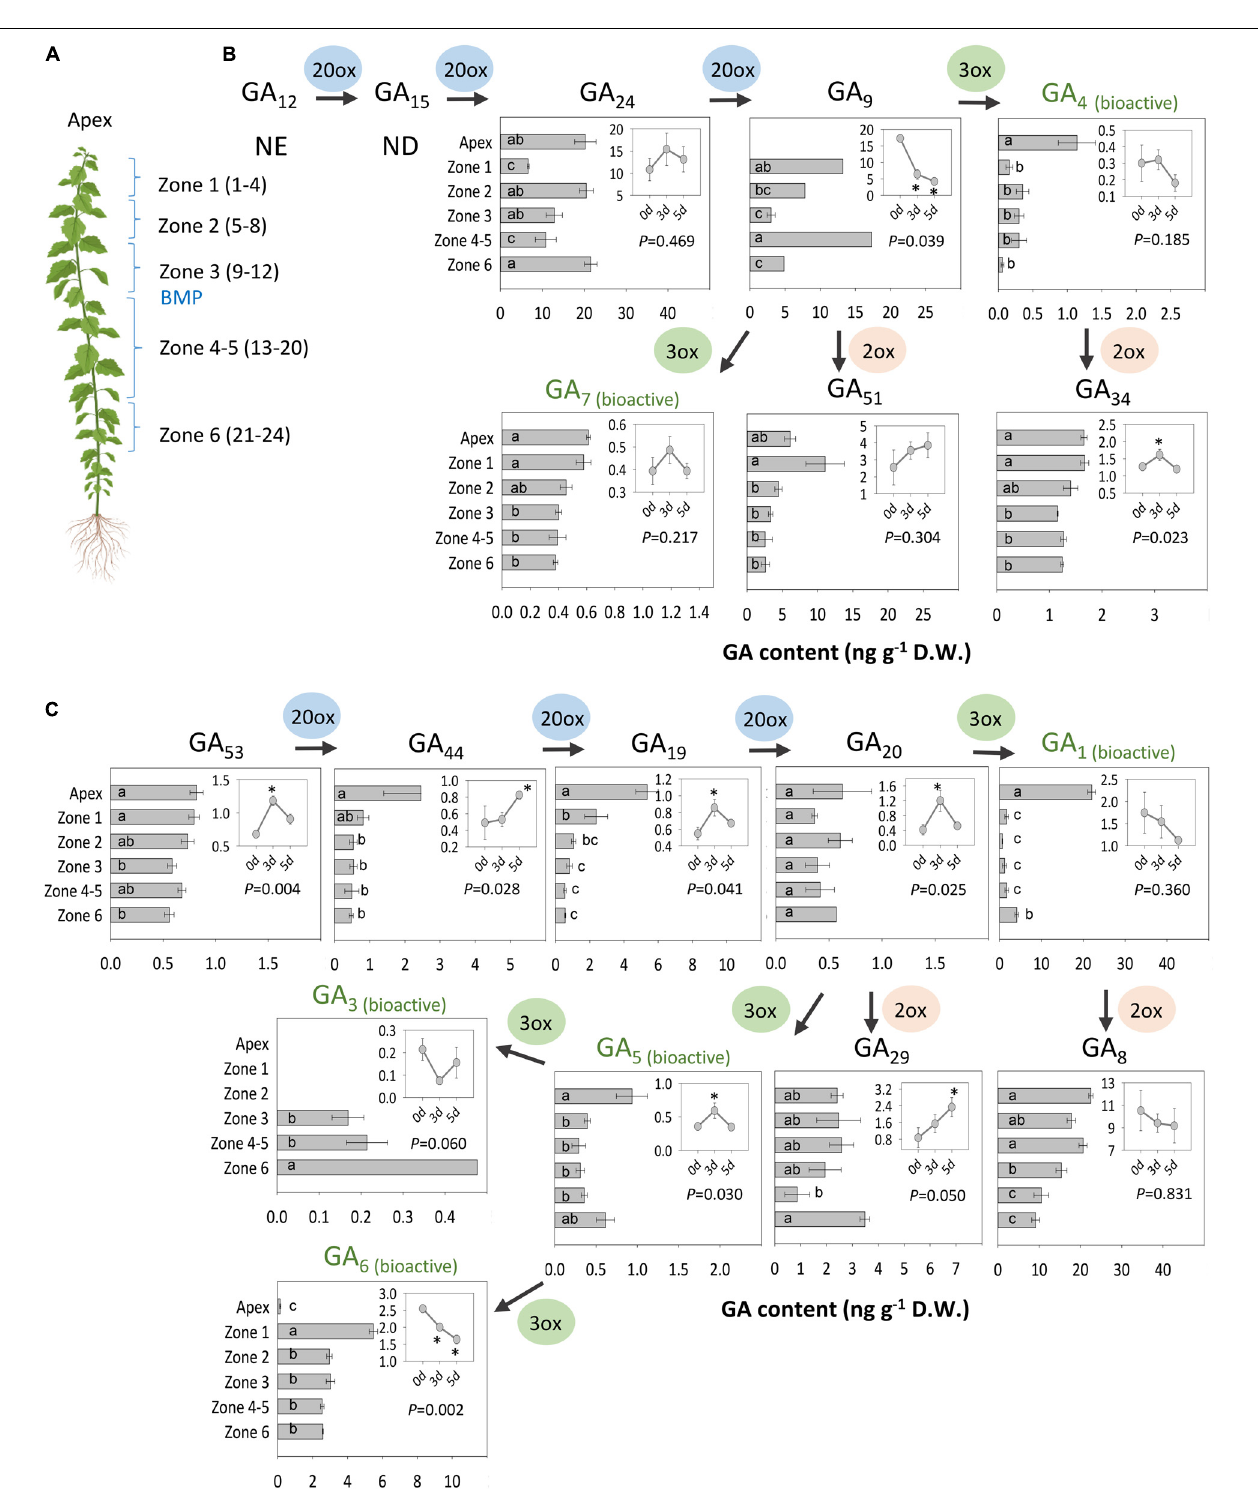
FIGURE 8 | Analysis of GAs. (A) Analyzed materials are indicated. The numbers in parenthesis of each zone refer to the position and the number of AXBs in each sample. GAs of the (B) non-13-hydroxylation and (C) the 13-hydroxylation pathway. Insets: Changes in GA levels 0, 3, and 5 days after decapitation in AXBs proximal to the decapitation point ( P -value shown). Asterisks in insets indicate statistically significant change in GA levels. Values represent the means of three biological replicates ± S.E. ( n = six plants). Different letters in bars indicate statistical differences in GA levels between the samples. NE, not estimated; ND, not detected. One-way ANOVA and pairwise post hoc analysis by Fischer’s LSD test ( P -value at least < 0.05).